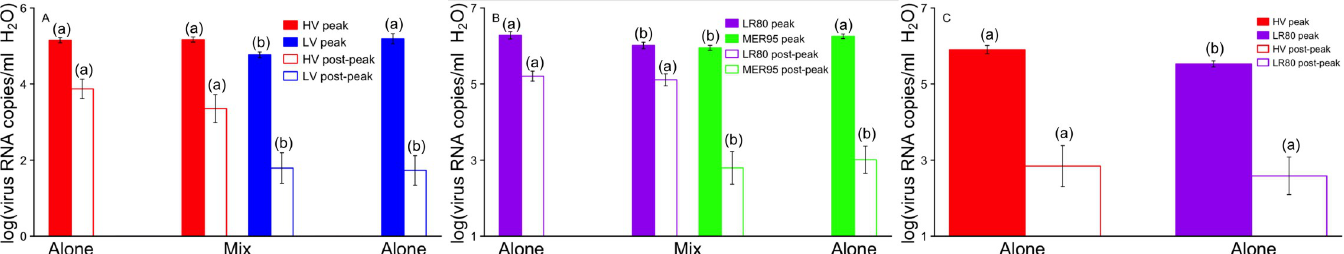
Fig 4. Total virus shed. Panels show mean total virus shed [log10(total virus RNA copies/ml H 2 O+1)] for the peak (days 0–4, filed bars) and post peak periods (days 5 onwards, open bars) for genotypes HV (red), LV (blue), LR80 (purple), and MER95 (green), in experiments 1 (A), 2 (B), and 3 (C). Single infections are shown on the panel edges and mixed infections together in the panel center, to denote that viral quantities for the two genotypes within an experiment in mixed infections came from the same fish. Error bars show +/- 1 standard error of mean. Shedding from all fish is included in the mean up to one day after fish death. For experiment 2, days 7 and 16 were excluded from total because only single infection samples were taken. Letters above bars (a and b) denote significant differences (P < 0.5, see text) between bars within panels and infection periods. Statistical comparisons were not made across panels (experiments) or infection periods (peak vs. post-peak). kinetics of viral shedding. During the peak period, for experiment 1 (Fig 4A) the analysis revealed that total shedding of the less virulent genotype (LV) was lower in mixed compared to single infections (Table G in S1 Text; genotype � competition interaction; Coef. 0.44 +/- 0.15, T = 3.05, P = 0.01). Genotype LV also shed less than the high virulent genotype (HV) in 1,18 = 8.15, P < 0.001). There was no differ- mixed infections (lsmeans, Coef. 0.40 +/- 0.05, T 1,18